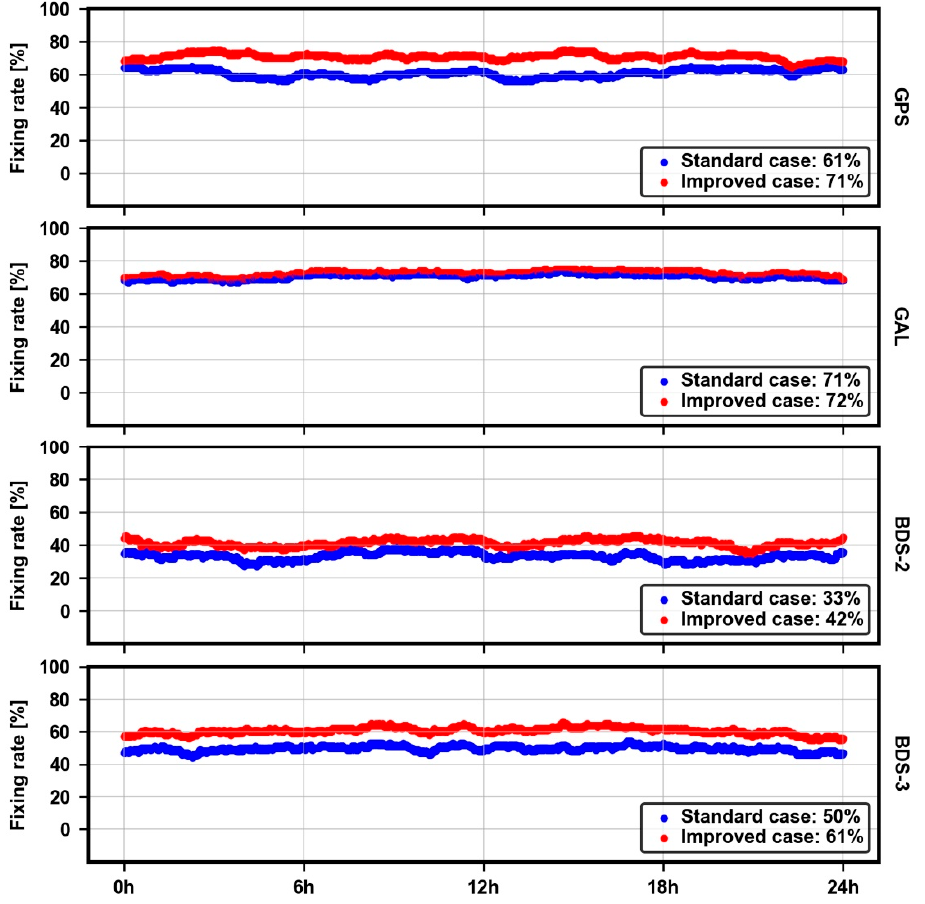
Figure 17. The NL ambiguity fixing rates for the standard case and improved case for the Case 4 network.